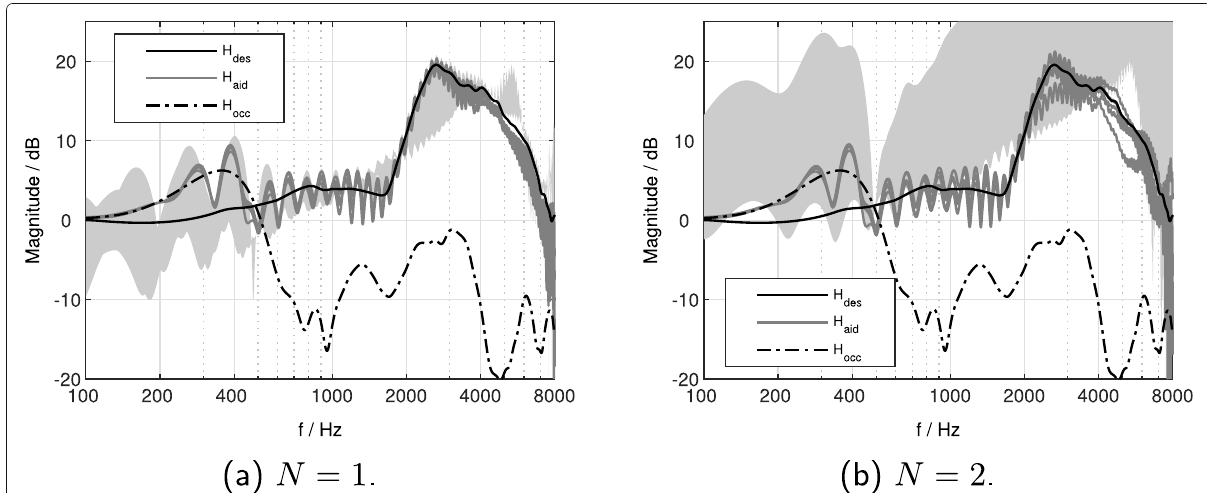
Fig. 8 Magnitude responses of the occluded ear transfer function H occ ( q ) , the desired open ear transfer function H des ( q ) and the aided ear transfer function H aid ( q ) for the robust optimization for a N = 1 and b N = 2 ( λ = 0.1, d G = 96, d H = 32, β = 1). The light gray-shaded area shows